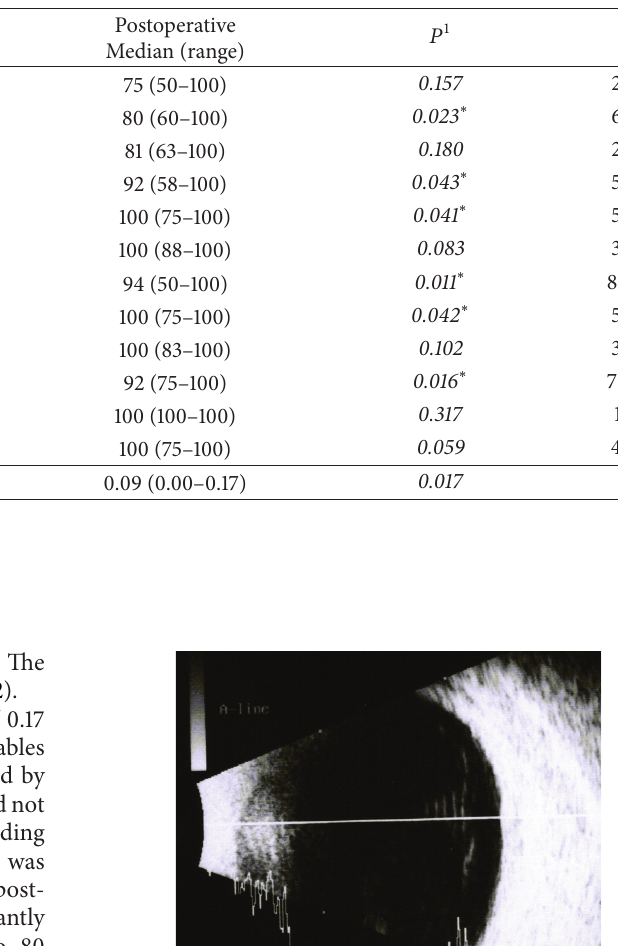
Table 2: Results of the VFQ-25 subscales and uncorrected visual acuity (UCVA) used to compare the preoperative period to the postoperative one.